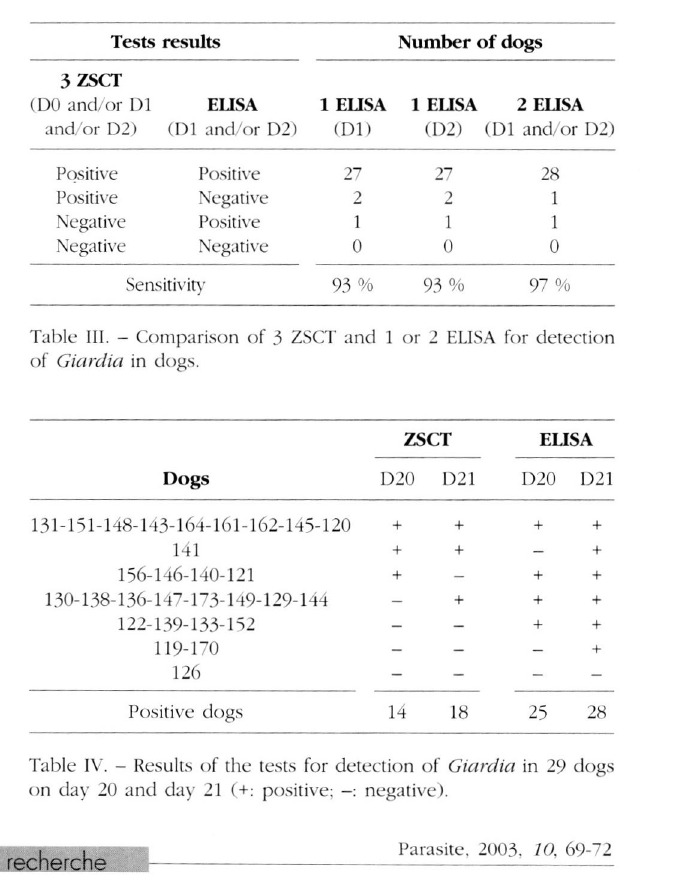
Table III. - Comparison of 3 ZSCT and 1 or 2 ELISA for detection of Giardia in dogs.